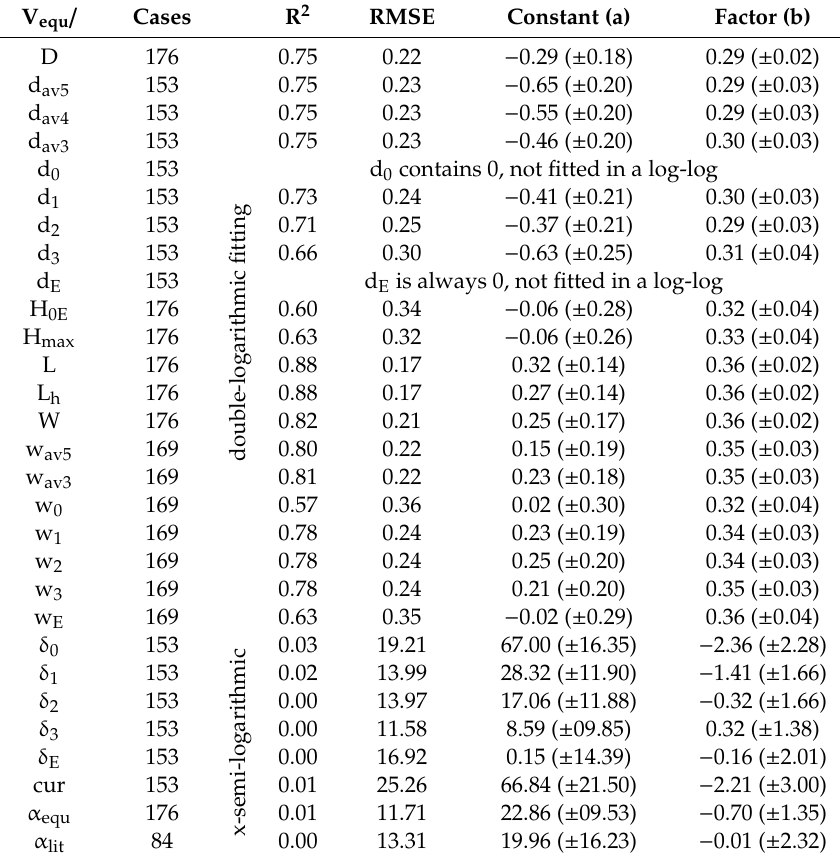
Table 3. Results for the volume-to-parameter correlations for the set “full”. For all dimension and shape-related parameters, the regression parameters (R 2 , RMSE, constant (a) and factor (b) with their 95% confidence intervals; Equation (2)) are given.